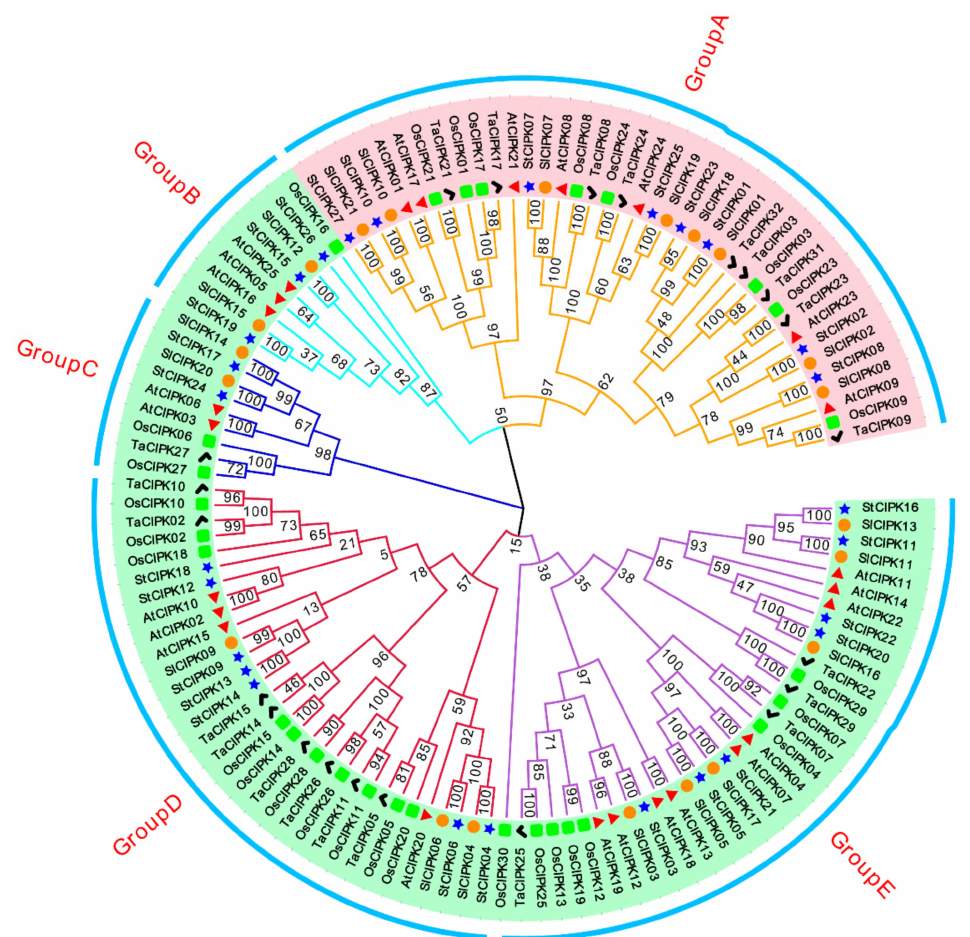
Figure 1. Phylogenetic relationships among plant CIPKs. Amino acid sequences of CIPKs were used to reconstruct a maximum likelihood phylogenetic tree using MEGA7 with the maximum likelihood method and 1000 bootstrap test replicates. At, Arabidopsis thaliana (red triangle); Os, Oryza sativa (green square); Ta, Triticum aestivum (black check mark); Sl, Solanum lycopersicum (orange circle); St, Solanum tuberosum (blue star). Red background indicates intron-rich CIPK genes; green background indicates intron-poor